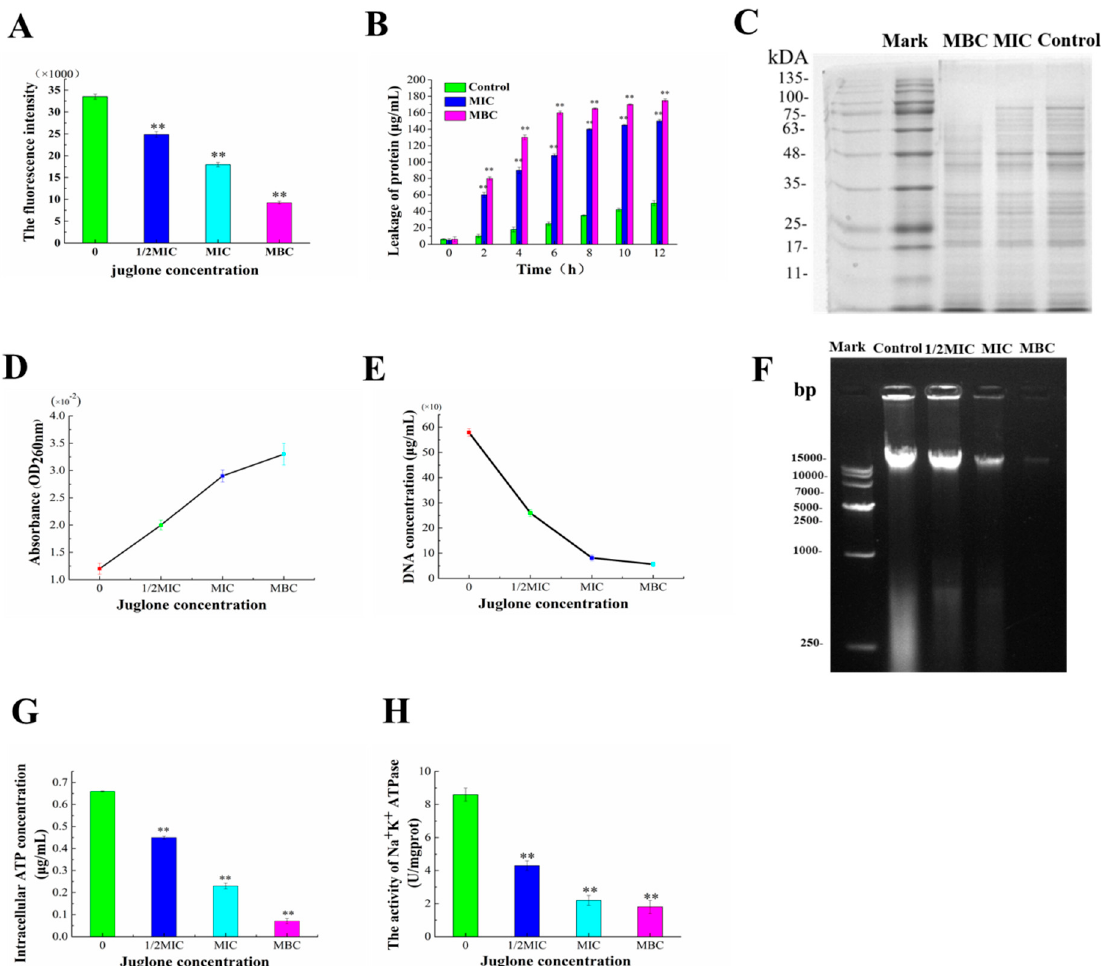
Figure 5. Effect of juglone on the intracellular substances of P. aeruginosa . The fluorescence intensity of DPH reflects the degree of cell membrane destruction in P. aeruginosa exposed to juglone ( A ). Leakage of extracellular proteins from P. aeruginosa treated with juglone ( B ). SDS-PAGE profile of intracellular proteins of P. aeruginosa ( C ). Intracellular and extracellular nucleic acid leakage of P. aeruginosa treated with juglone ( D , E ). DNA gel electrophoresis analysis ( F ). Effect of juglone on intracellular ATP concentration and ATPase activity of P. aeruginosa ( G , H ). Each bar represents the mean ± SD of three independent experiments; ** p < 0.01 versus the control group.